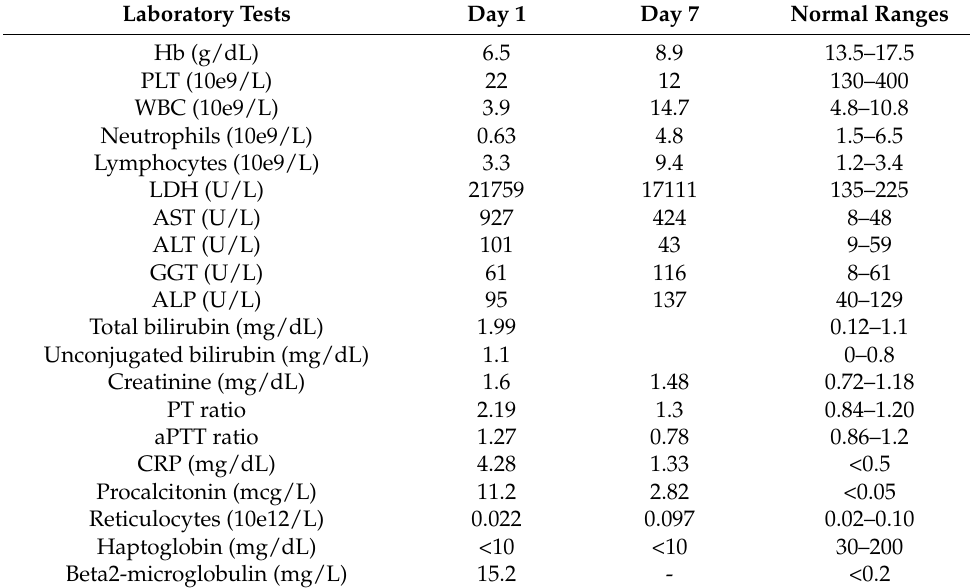
Table 2. Laboratory exams of Patient